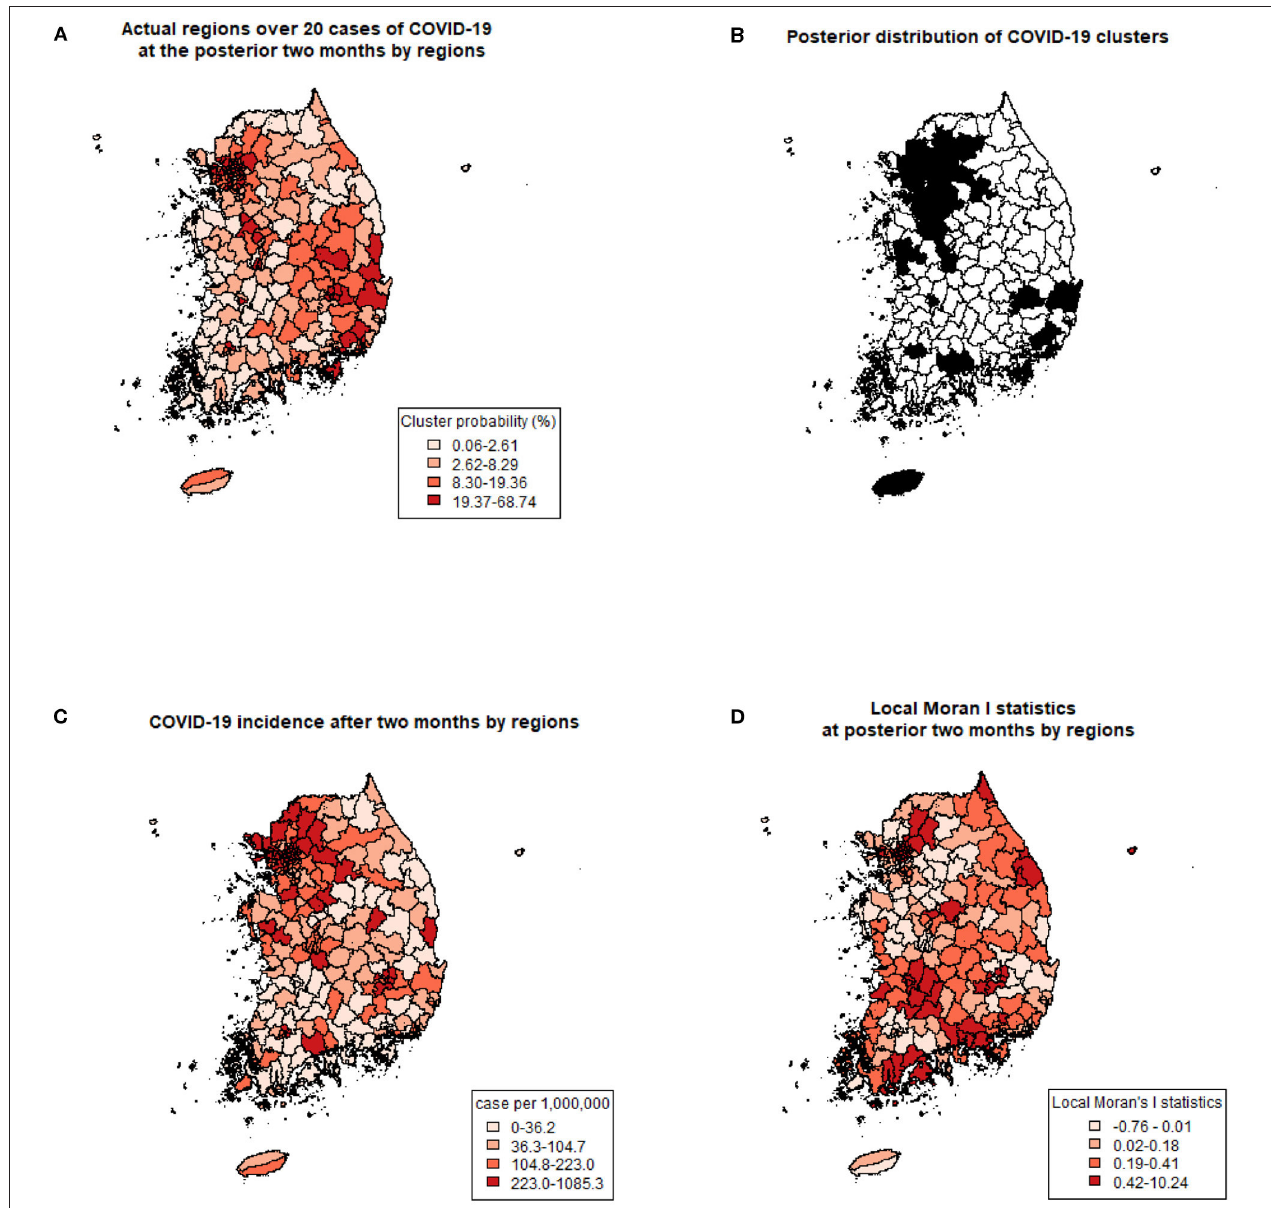
FIGURE 2 | Comparing predicted clusters and actual COVID-19 with three criteria. (A) Prediction of COVID-19 clusters by posterior probabilities of the spatial cluster model. (B) Actual regions with more than 20 COVID-19 cases at the posterior 2 months of the study period. (C) COVID-19 incidence (number of cases per 1,000,000) after 2 months of the study period. (D) Local Moran’s I statistics at posterior 2 months of the study